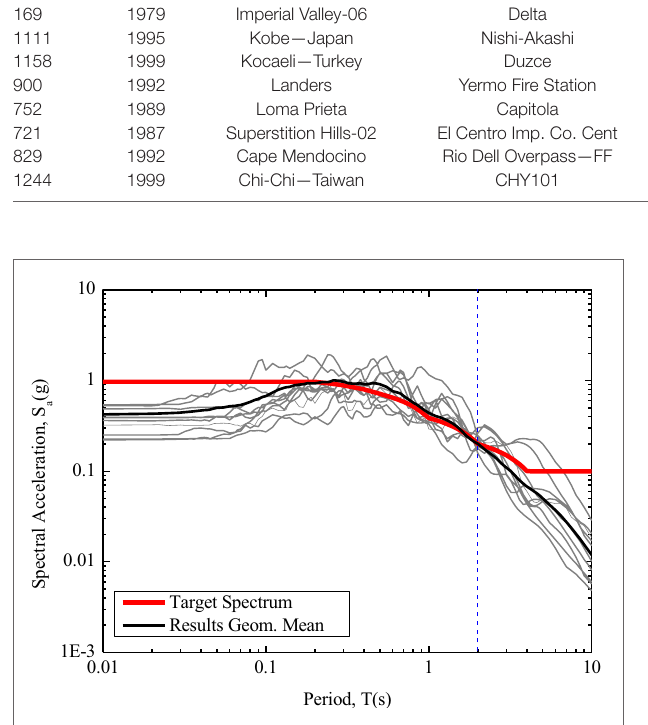
FigUre 10 | Earthquake records scaled to target spectrum (5% damping) at 1.97